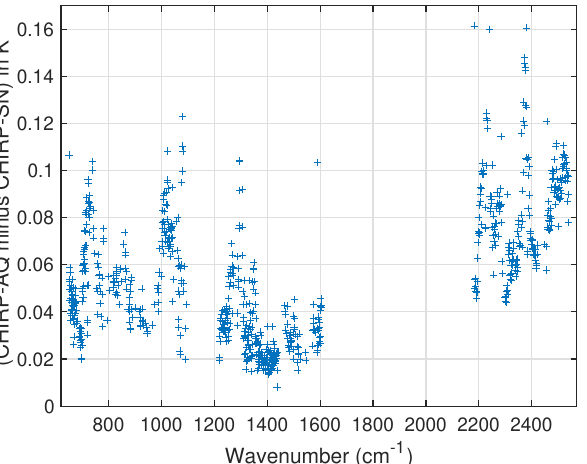
Figure 13. The standard deviation in K of the quantile differences shown in Figure 12, taken over the 100 cumulative probability quantiles. Only channels where the CHIRP-AQ fill values are less than 0.02 are